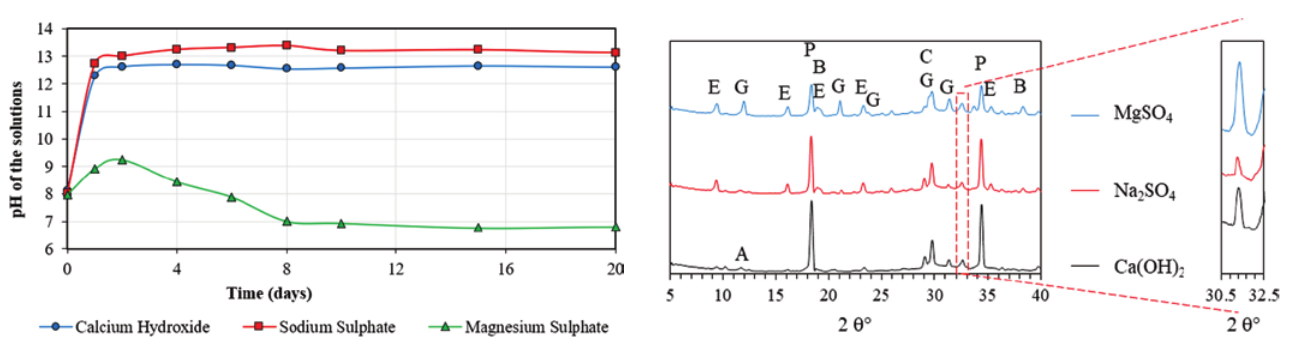
Figure 9 LF diffractograms after 20 weeks of exposure to , Na SO 2 2 4 Ca(OH) , Na SO and MgSO . 2 2 4 4 Monocarboluminate (A), brucite (B), calcite (C), ettringite (E), gypsum (G) and portlandite (P)